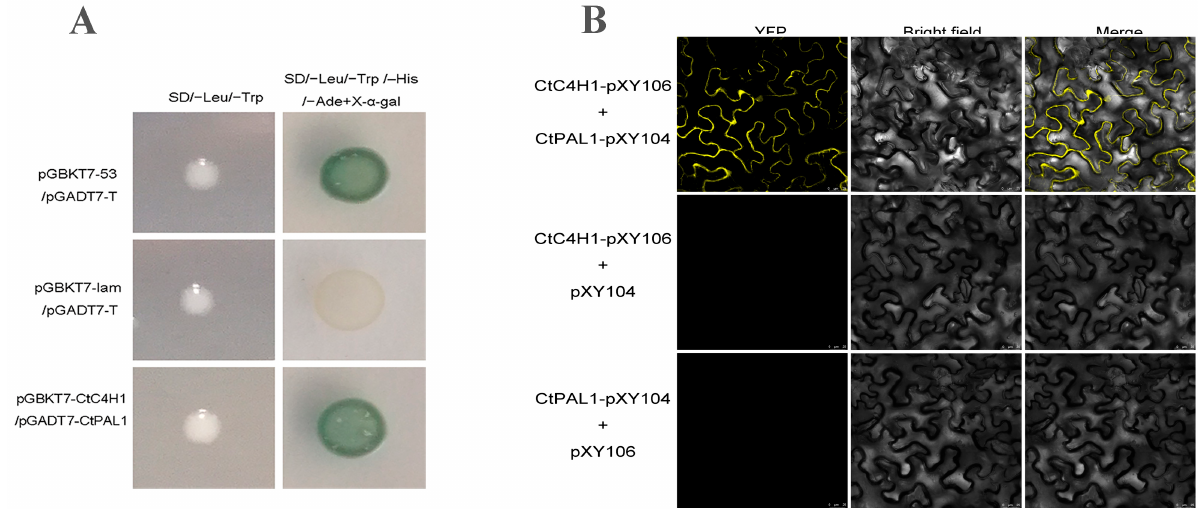
Figure 4. The interaction of CtC4H1 and CtPAL1 in tobacco ( A ) Yeast-two-hybrid assay of CtC4H1 and CtPAL1. ( B ) BiFC analysis. Fluorescence was observed in tobacco leaf epidermal cells. Scale bars = 25 μ m.